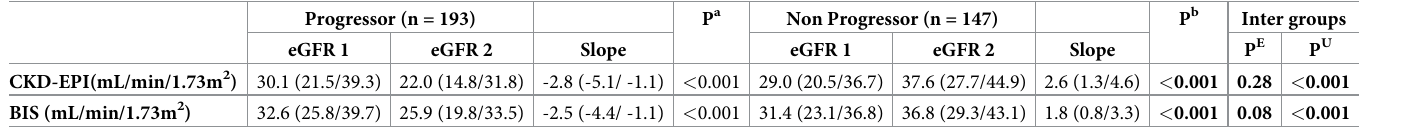
Table 2. Comparison of renal function and progression parameters inter groups.